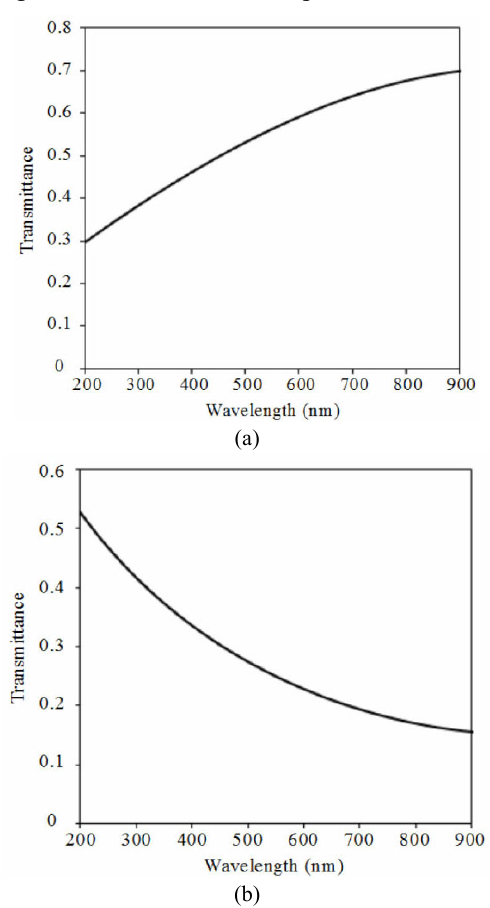
Fig. 1 Average transmittance (a) and absorbance (b) of